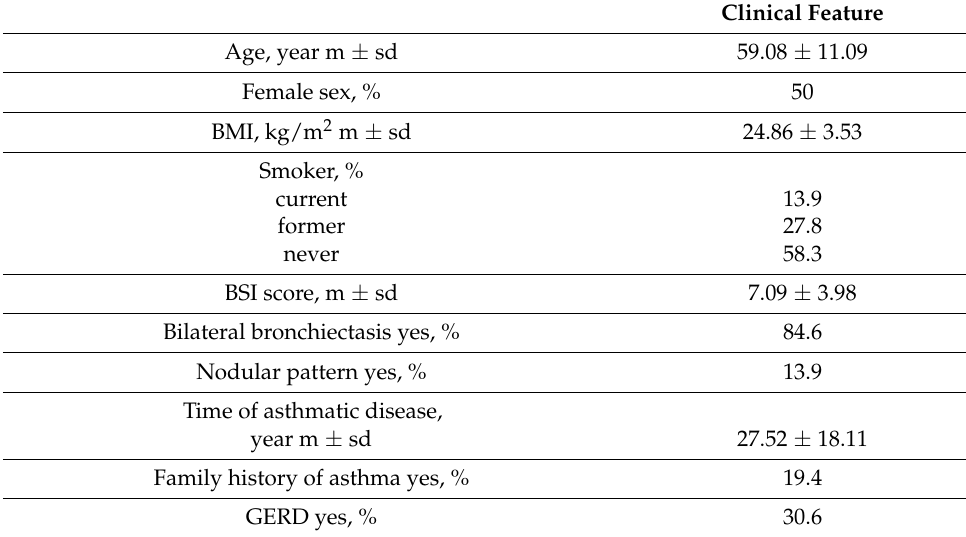
Table 1. Patients’ characteristics, asthmatic disease time, comorbidities related to asthma, radiological severity of bronchiectasis, type of biological therapy